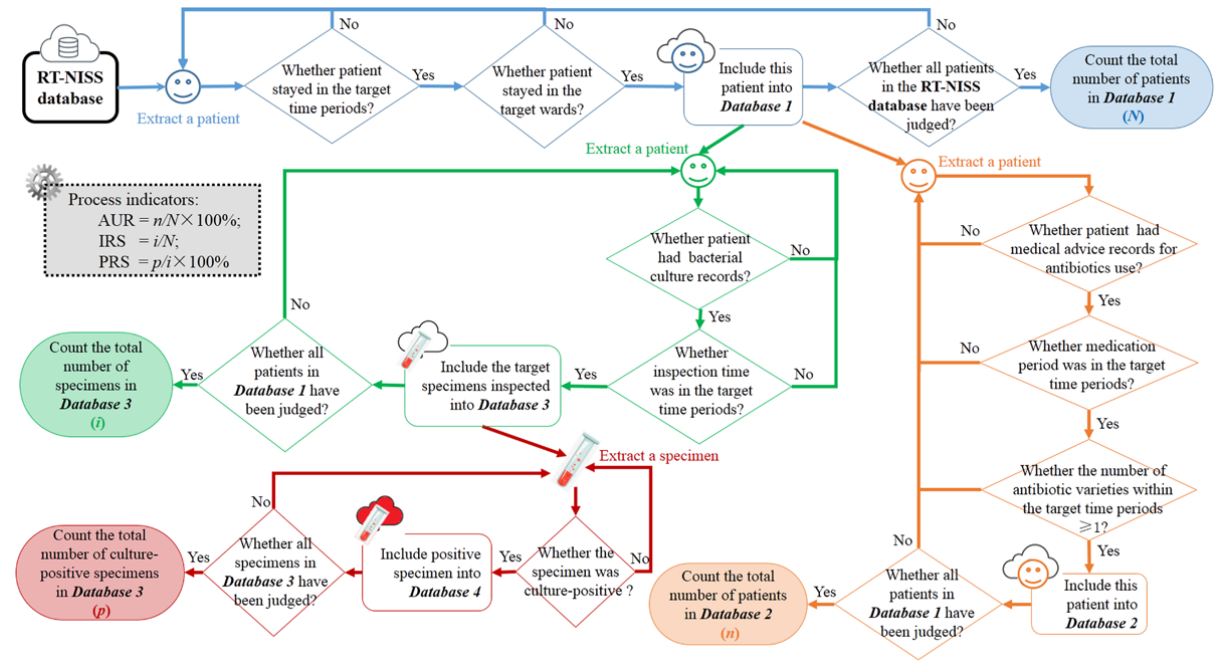
Figure 1. The flow diagram of data extraction process of the variables used to calculate the process indicators. RT-NISS: Real-time nosocomial infection surveillance system; AUR: Antibiotic utilization rate in combination; IRS: Inspection rate of bacterial specimens; PRS: Positive rate of bacterial